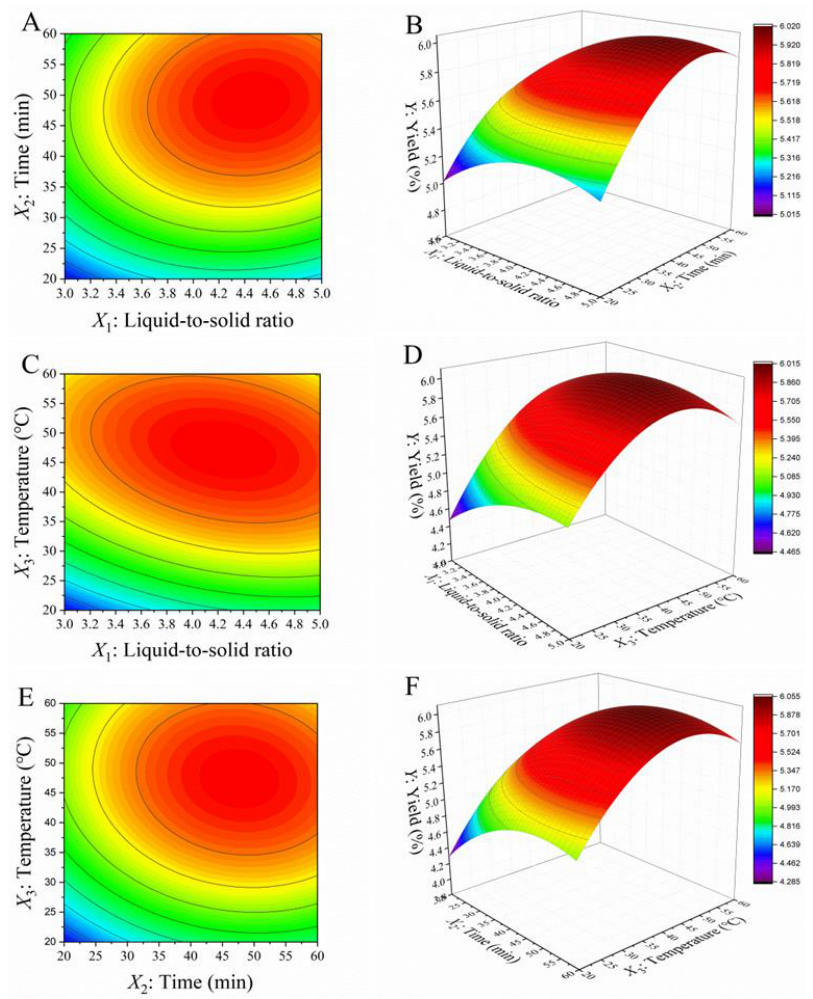
Figure 1. Contour plots ( A , C , E ) and response surface plots ( B , D , F ) of the extraction yield affected by liquid-to-solid ratio, time, and temperature.